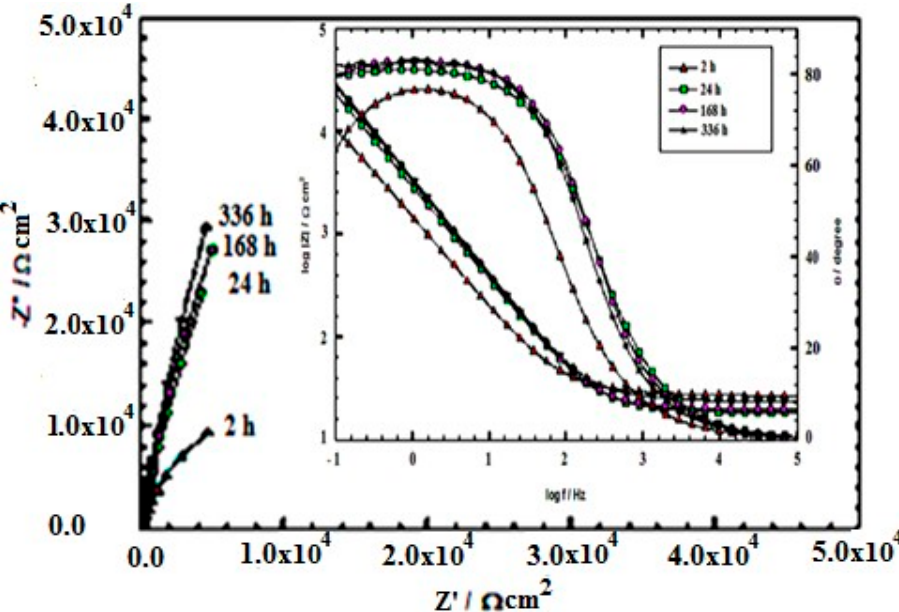
Figure 4. Nyquist plots of bare Ti alloy with Bode plot insets after immersion in artificial saliva at 37 °C.